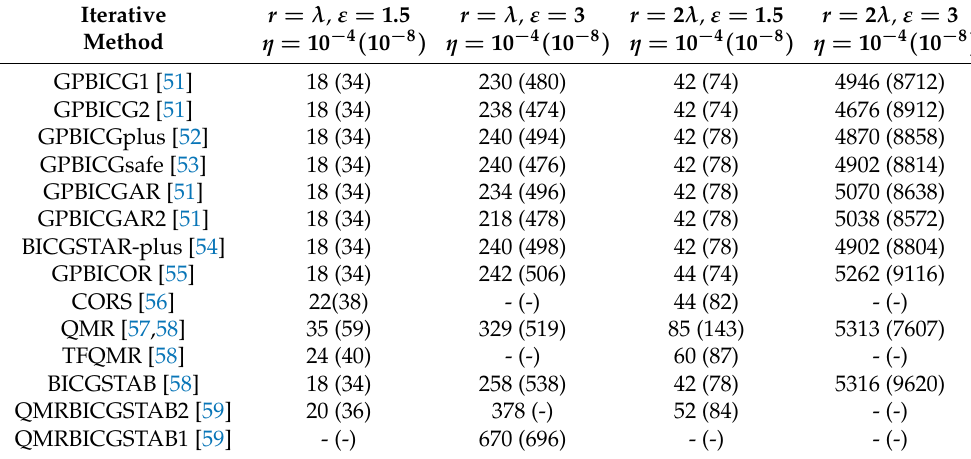
Table 1. Number of MVP for different iterative method for two values of η to solve Equation (15). The object is a sphere of radius r and relative permittivity ε . The mesh size is d = 2 r /30 for r = λ ( N = 14,328) and d = 2 r /50 for r = 2 λ ( N = 65,752). The symbol - means that the convergence of the iterative method has not been achieved. The computation are conducted with the IF-DDA code [10] and the maximum number of MVPs for iterative methods has been set at